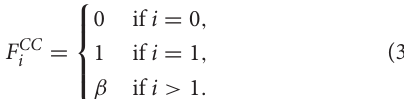
5 and i is the number of infected =